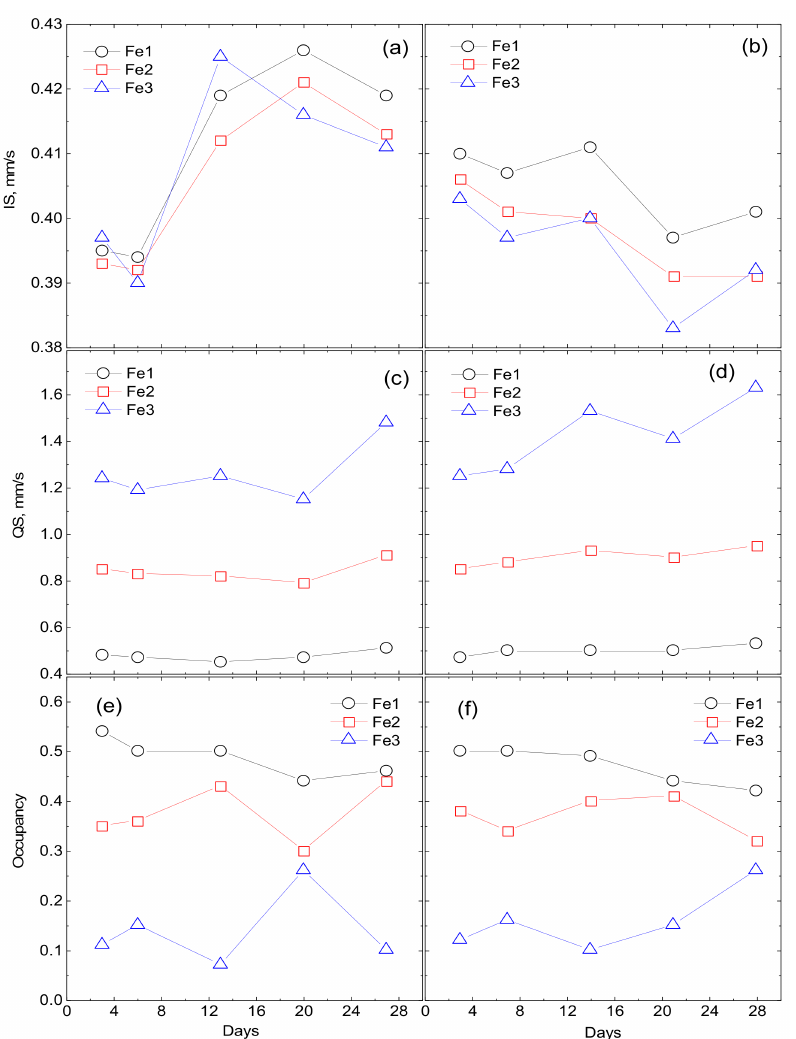
Figure 5. Dependencies of site occupancies, isomeric shifts (IS) and quadrupole splittings (QS) on the cultivation duration. Fe 2+ denotes oxalate medium ( a , c , e ) and Fe 3+ denotes citrate medium ( b , d , f